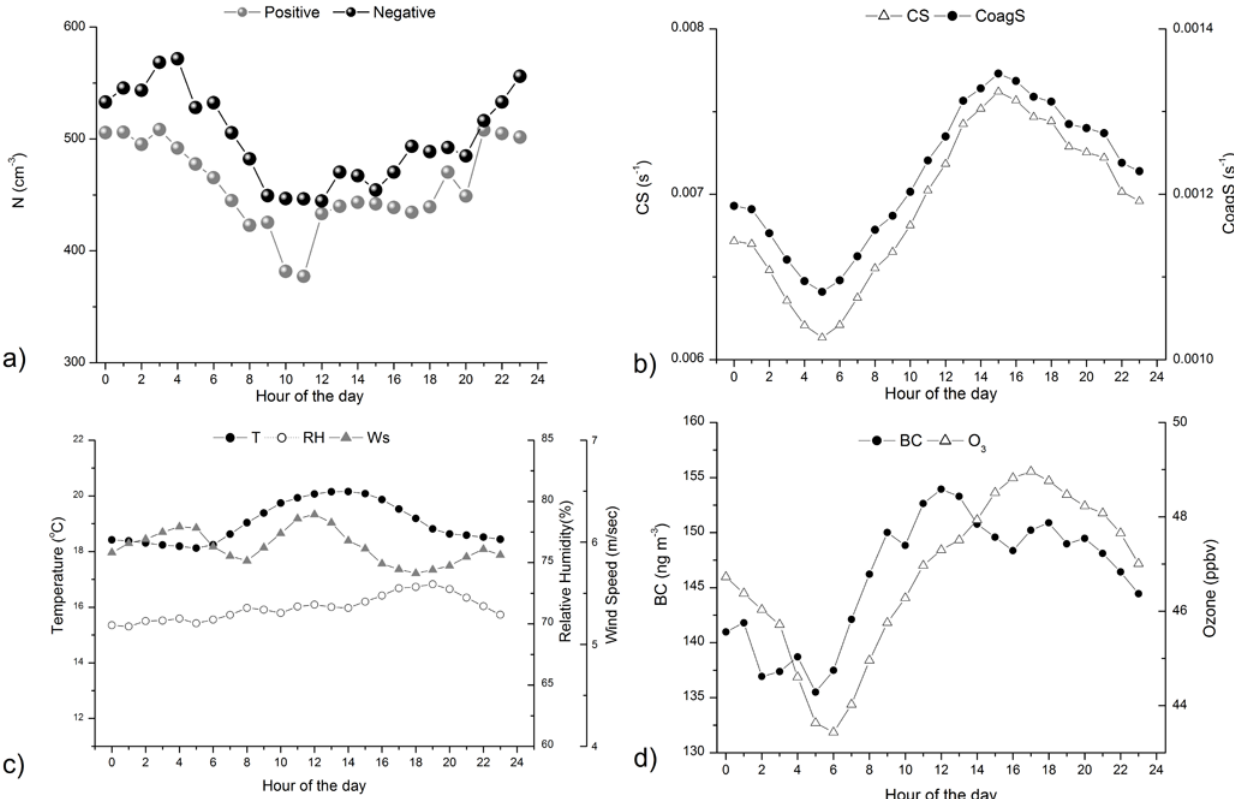
Fig. 2. Median diurnal cycles (hourly averages), at Finokalia of (a) Atmospheric ion concentrations in the size range 0.8–42nm (b) CS and CoagS, (c) T , RH and W s and (d) BC and ozone.